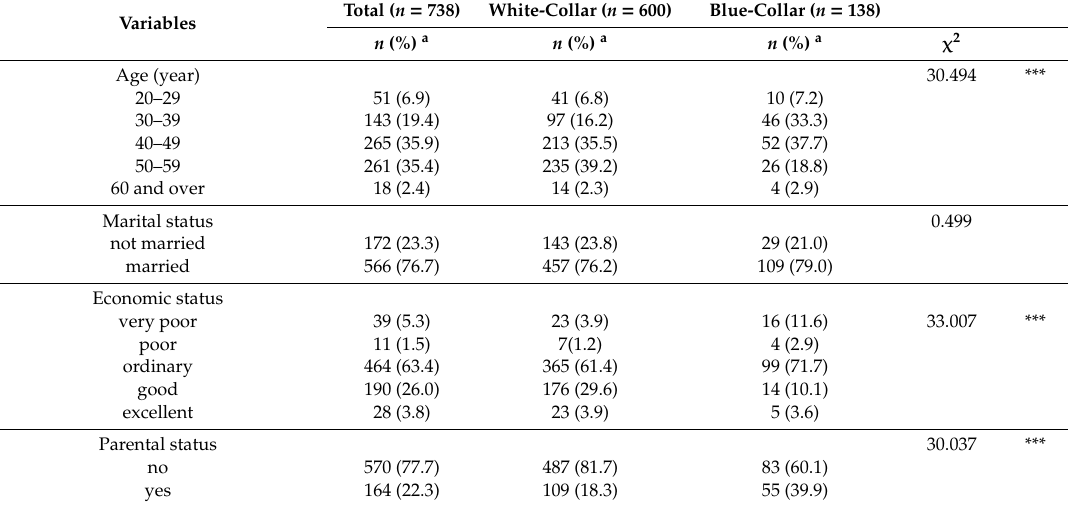
Table 1. Comparing demographic characteristics and research variables by